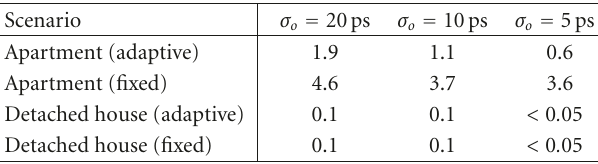
Figure 12: Bit-rate values obtained with the modified LS estimator and M = 3. Table 2: Average bit-rate loss (%) in each scenario with the modi- fied LS estimator and M = 3 when using the optimum loop band- width (on